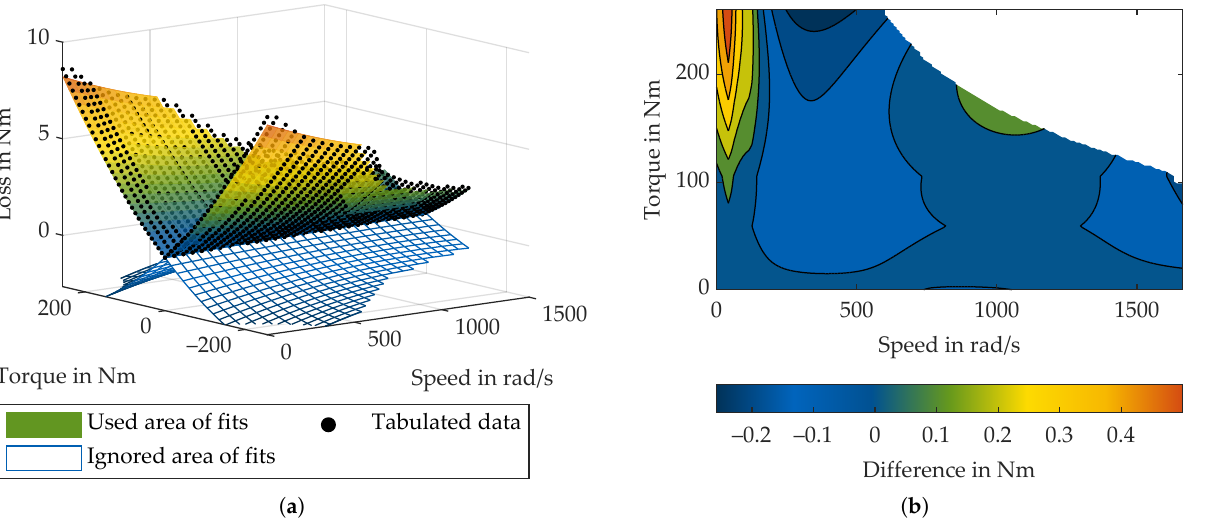
Figure A5. ( a ) Gearbox losses of ID.3: fits of the split meta-model and the corresponding data points of the tabulated model. The ranges used due to the inequality constraints of Equations (36) and (37) are highlighted with surface color. Irrelevant ranges of the fits are presented with grid lines only. ( b ) Difference between fit and tabulated gearbox